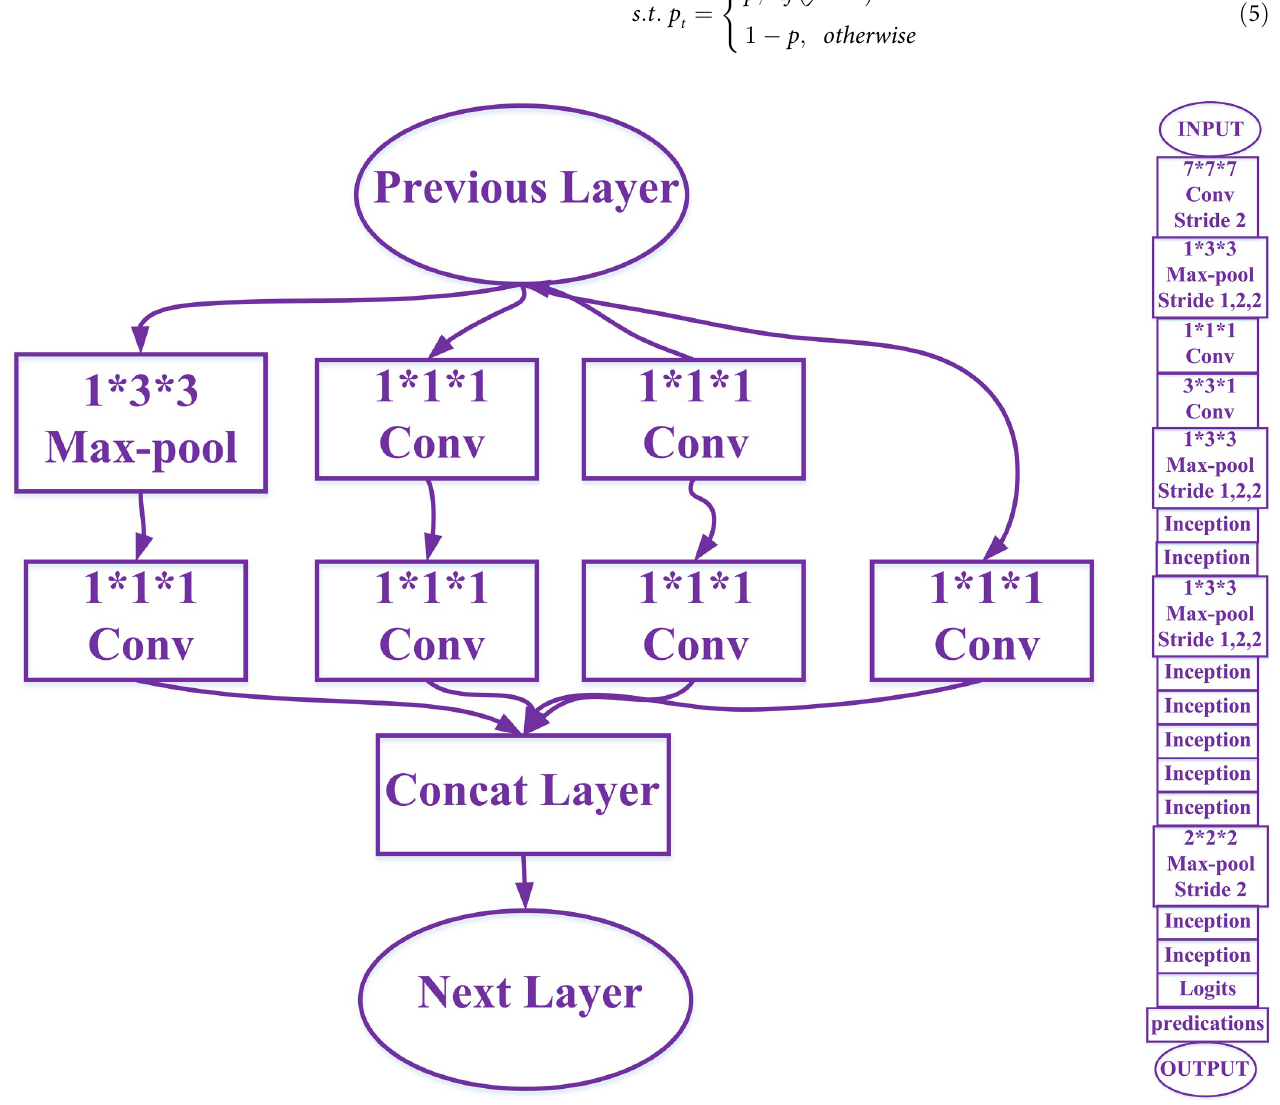
Fig 8. The left side is inflated-3-dimensional network, and the right side is the inception structure.